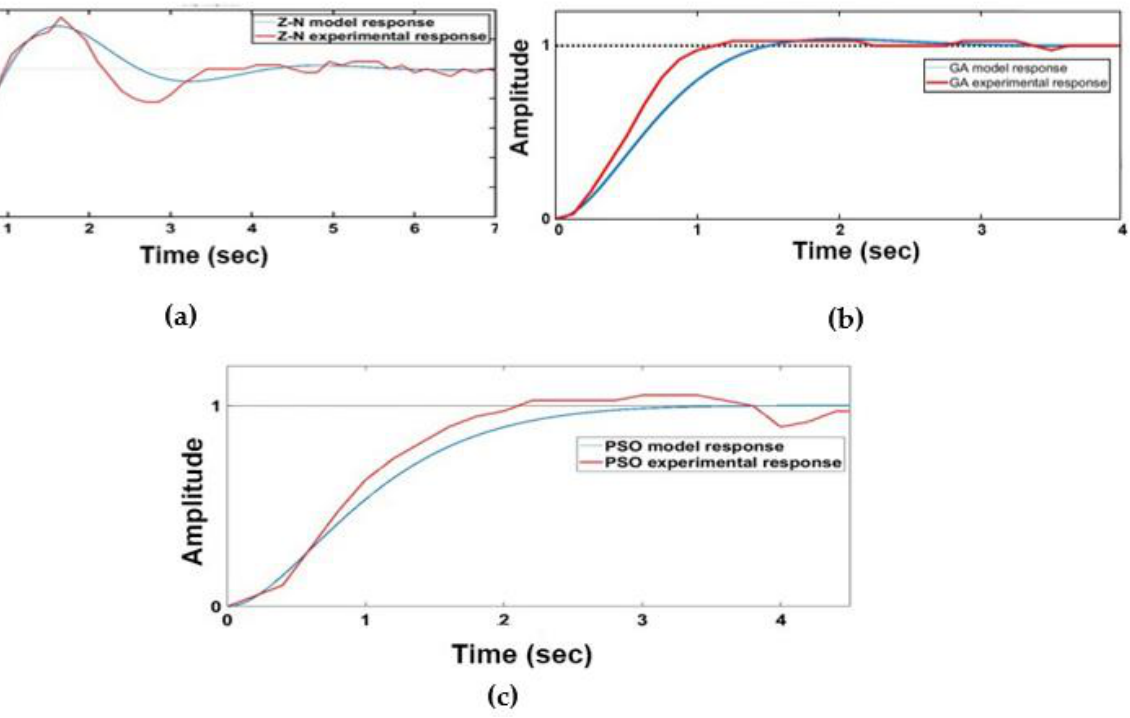
Figure 12. ( a ) Model & Experimental results by using Z-N method; ( b ) Model & Experimental results by using GA method; ( c ) Model & Experimental results by using PSO method.